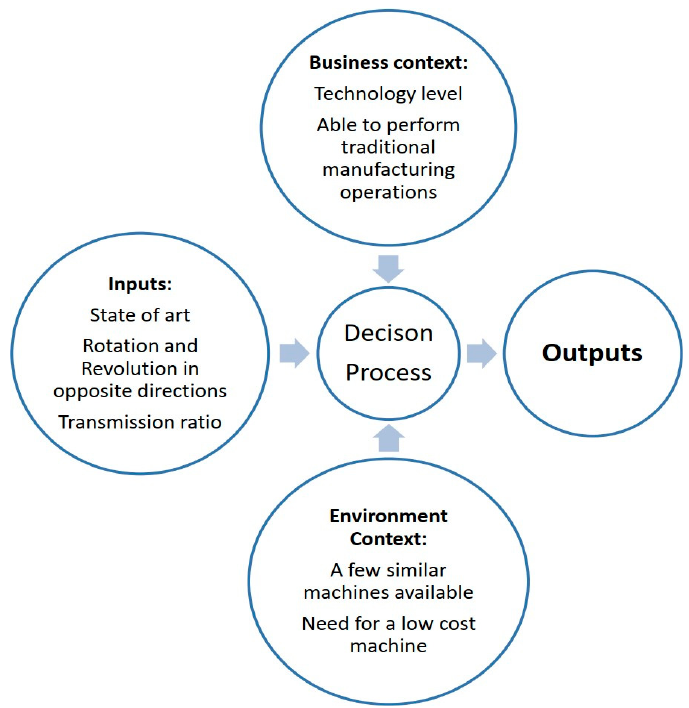
Figure 2. Flow chart for the decision process applied to the project of a planetary ball mill developed by a medium-sized company.